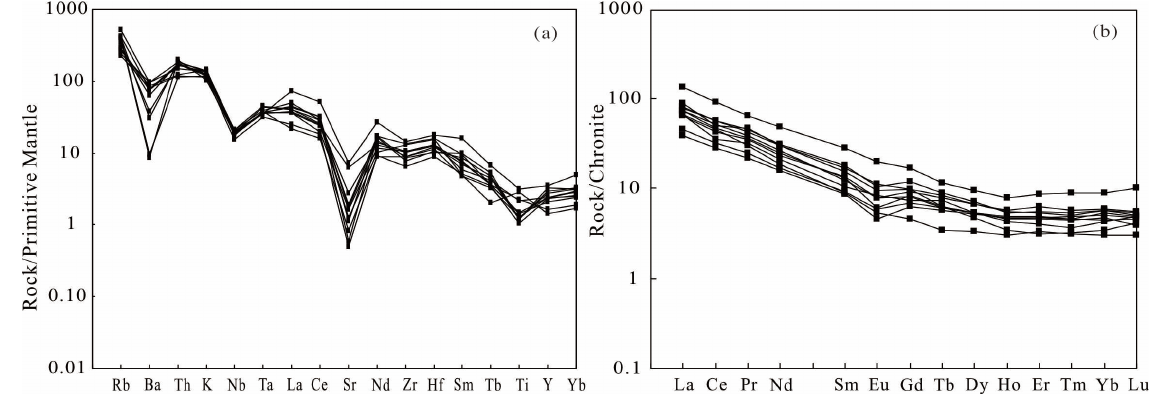
Figure 4. ( a ) Normalized trace element patterns for the Dongxiang granodiorite porphyry; ( b ) REE patterns for the Dongxiang granodiorite porphyry. Chondrite and primitive mantle data are from Boynton,1984, respectively [42].